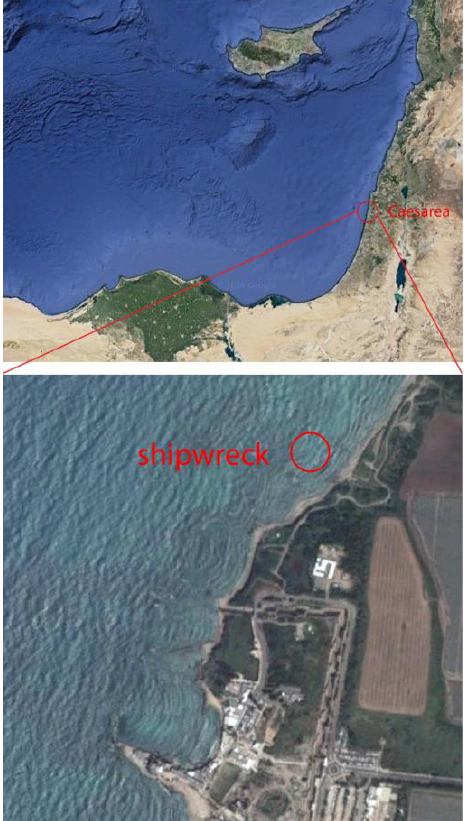
Figure 1: Aerial view of the excavation. Note in the foreground the support boat for the excavation and in the back on the left the Herodian harbour (photo: H. Nativ/Morris Kahn Marine Research Station).